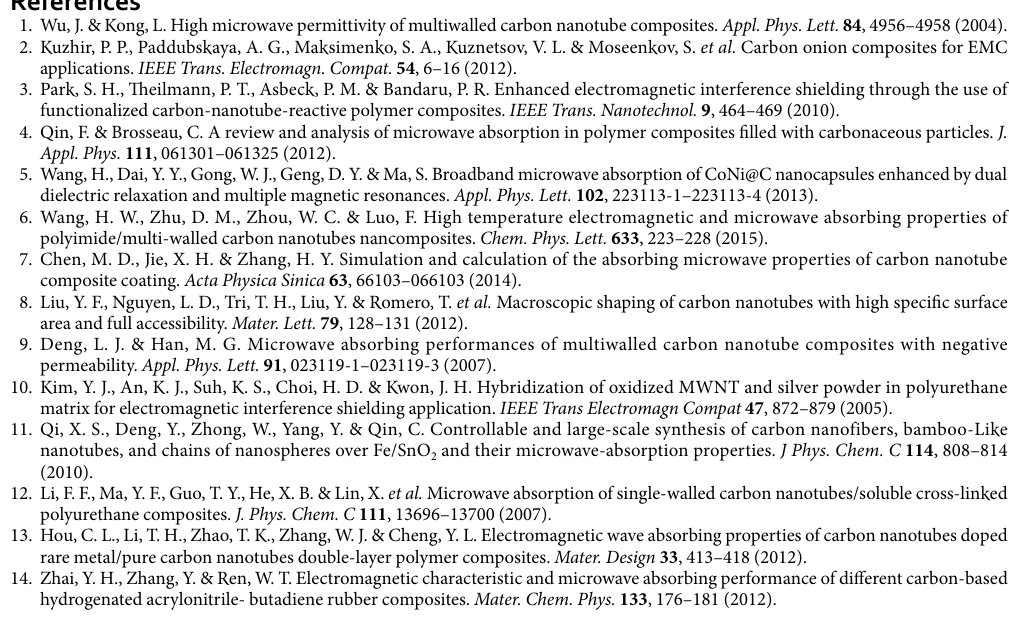
CNTs further tailored by controlling the heat-treatment temperature and time of the CNTs. This could ensure fulfillment of requirements for various frequency band and bandwidth. Figure 9 shows the measured reflectivity curve of a 3-mm-thick composite coating with a CNT content of 15 wt.%; this curve is obtained via the Arch method. As shows in Fig. 9, the absorption peak of the compos- ites treated at 700 °C has a minimum value of − 15.2 dB (8 GHz). The corresponding peak of the composite heat-treated at 900 °C has a minimum value of ∼− 14.2 dB (11 GHz). This trend is relatively consistent with the simulated results. The theoretical and experimental studies on CNT composites reveal that the interface prop- erties of CNTs are influenced by the heat-treatment process. These properties will ultimately influence the elec- tromagnetic factors and microwave-absorption characteristics. The effect of interfacial polarization was also demonstrated by comparing the microwave-absorption characteristics of CNT/polymer and decorated CNT/ polymer composites 23–25 . These observations indicate that strong interfacial polarization is essential for high microwave absorption.